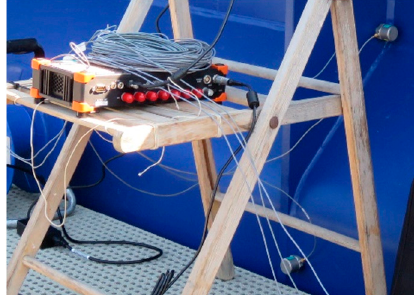
Figure 12. A view of the SIRIUS data acquisition station and the left main girder with two 8344 accelerometers attached in the center of the main span of the bridge.